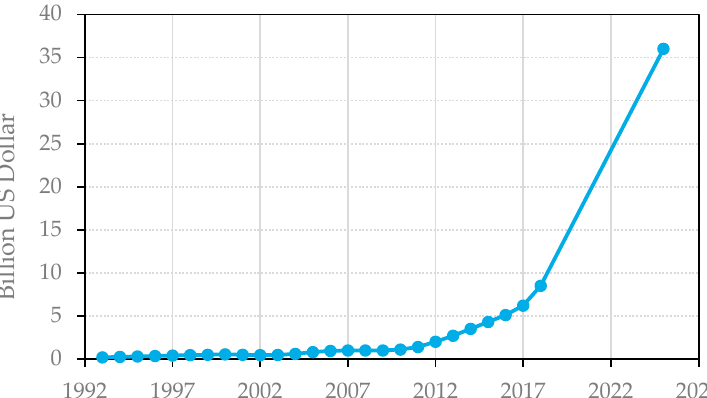
Figure 2. Total revenue for the additive manufacturing market in the world from 1993 to 2018 and a forecast for 2025 in billion dollars (adapted from [9]).